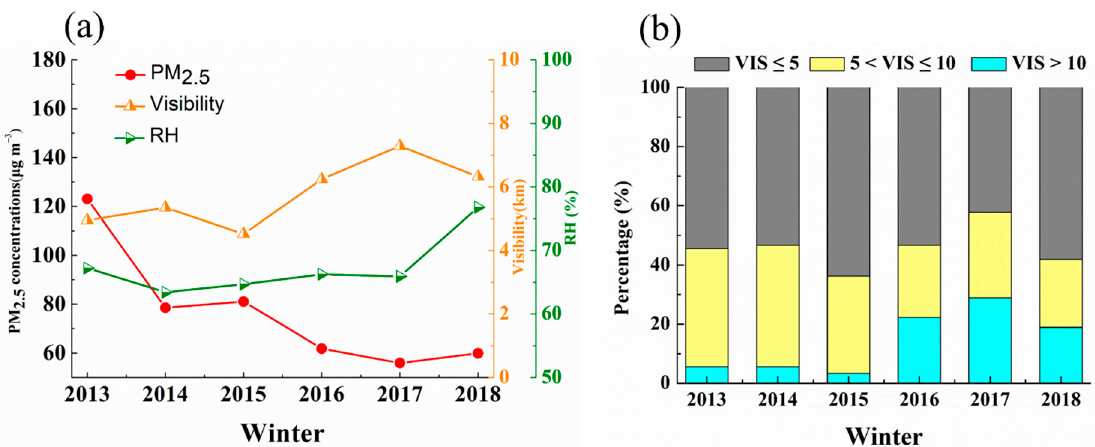
Figure 3. Interannual variations of wintertime ( a ) Fine particulate matter (PM 2.5 ) concentrations, visibility, relative humidity (RH) and ( b ) the percentages (%) of days with good (VIS > 10 km), low (5 km < VIS ≤ 10 km), and poor (VIS ≤ 5 km) visibility in winter observed in Nanjing from 2013 to 2018. Table 1. Correlation coefficients of daily visibility with PM 2.5 concentrations and RH in Nanjing during wintertime of 2013–2018 (passing the confidence level of 99%). Winter Visibility vs. PM 2.5